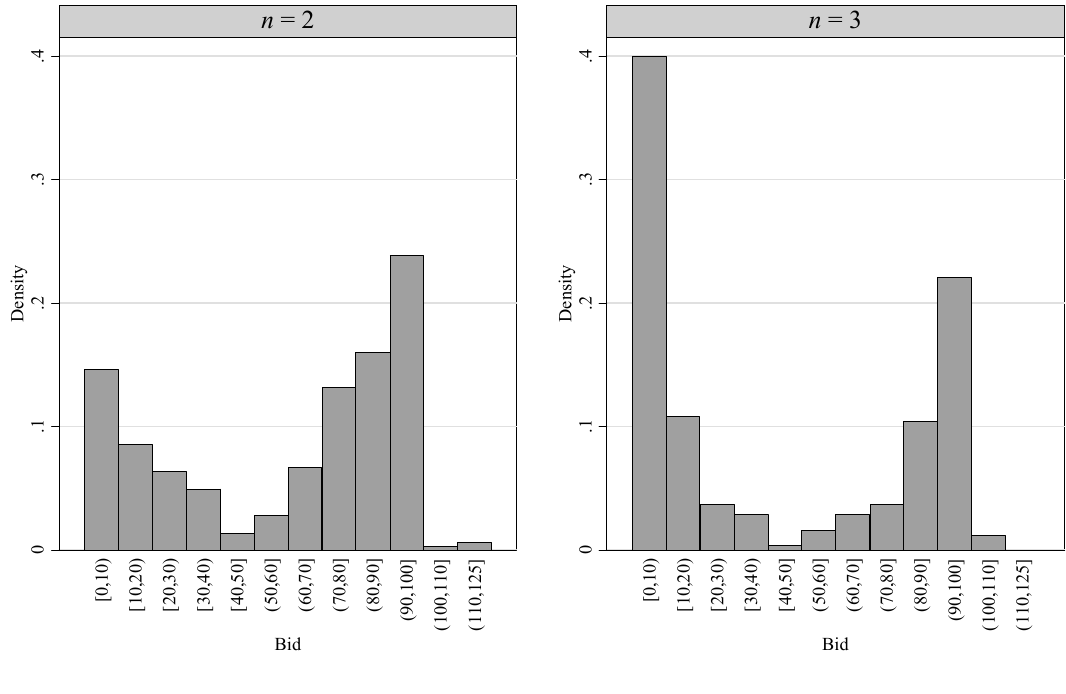
Figure 4. Histogram of bids in groups of two and three subjects in the NoRecall